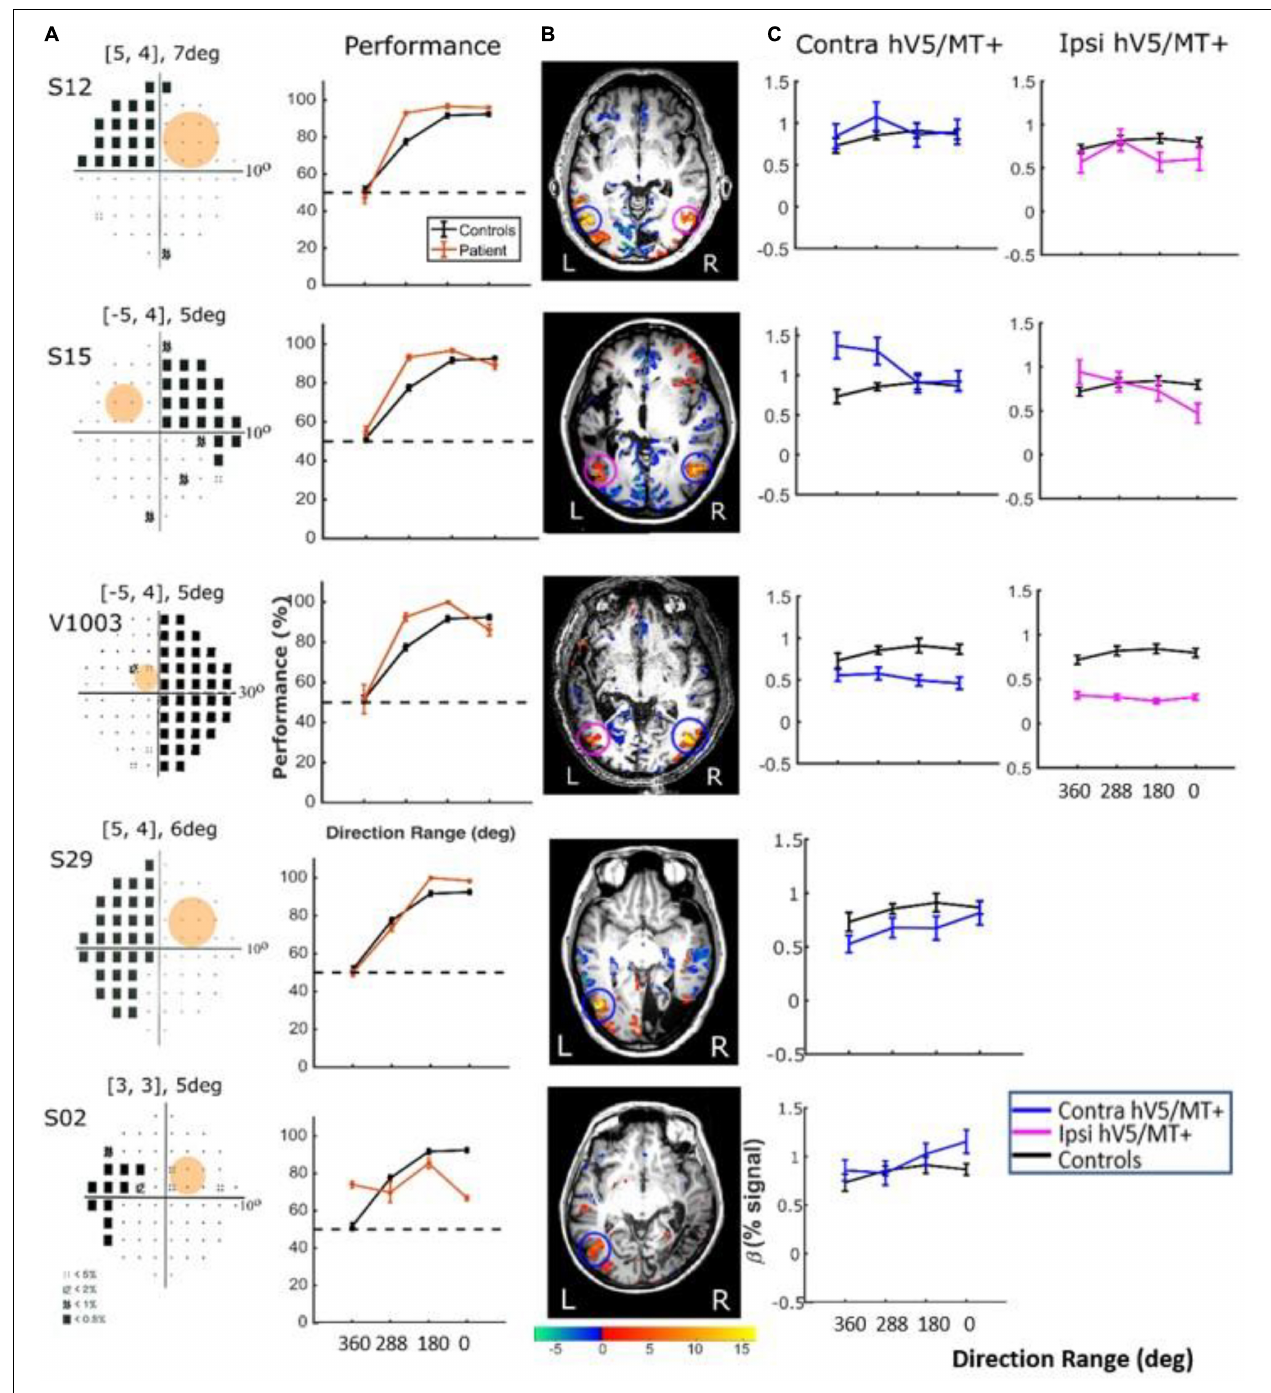
FIGURE 9 | Behavioral performance and hV5/MT+ responses to motion coherence within the sighted field of patients performing a motion direction discrimination task. (A) Left column: Visual field deficits for each patient based on perimetry and location of the stimulus aperture (orange disk). Right column: Behavioral performance for the motion direction discrimination task when the stimulus is presented within the sighted field of patients (orange) versus control subjects (black). (B) Activation maps when the stimulus was presented within the sighted visual field. We found significant activity for both the contralesional (blue circle) and ipsilesional (magenta circle) hV5/MT+. (C) Mean GLM β weights of contralesional (blue) and ipsilesional (magenta) hV5/MT+ across patients as a function of coherence level compared with control subjects